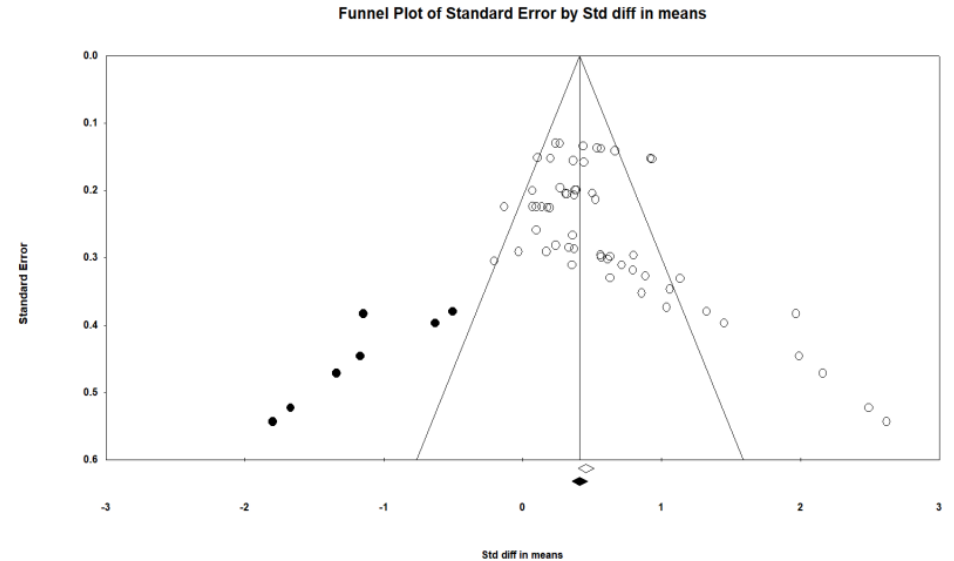
Figure 2. Funnel plot.